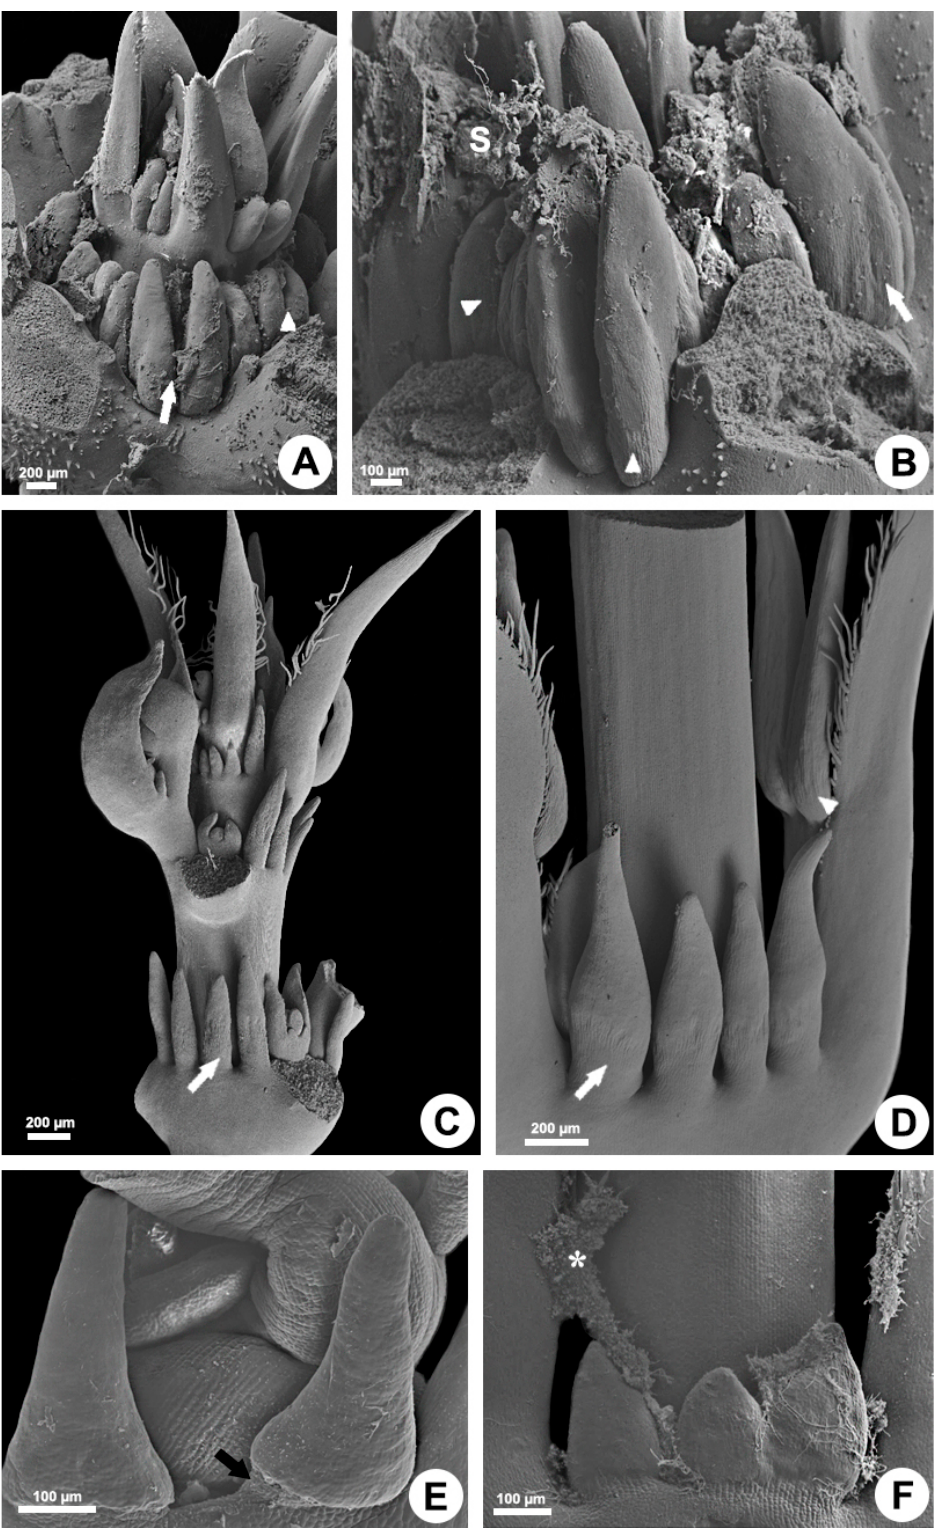
Figure 1. Morphology of the colleters of Allamanda schottii ( A , B ), Blepharodon bicuspidatum ( C , D ), Mandevilla splendens ( E ), and Peplonia axillaris ( F ). Scanning electron microscopy. White arrows = interpetiolar colleters; Black arrow = colleter stalk; Triangle = petiolar colleter; Asterisk = fungi; S = secretion.